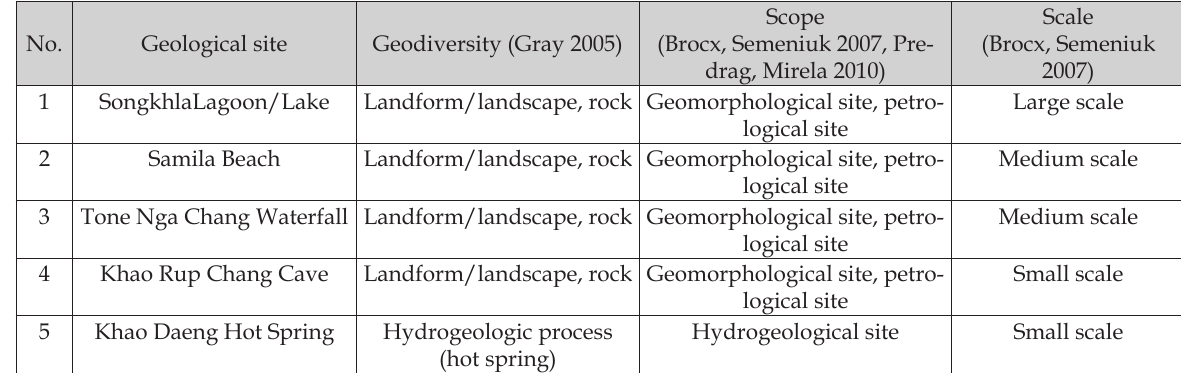
Table 2. Classification of some selected geosites in Songkhla Province,